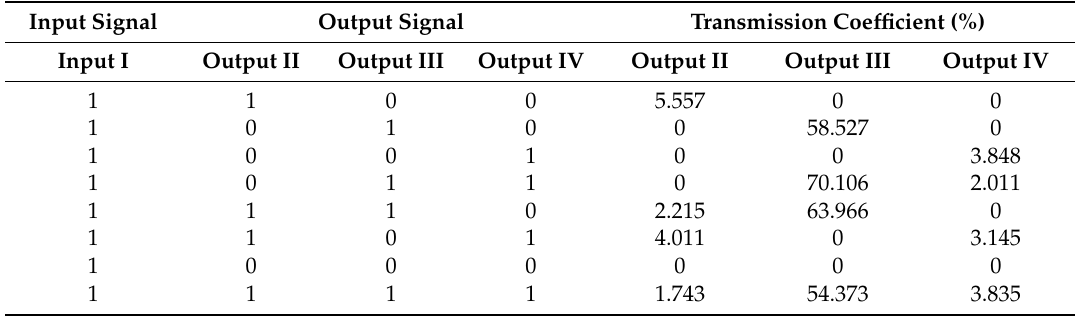
Table 3. Transmission coefficients of the single-input three-output switch at different logical states. Input